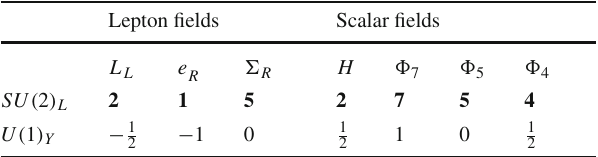
Table 1 Contents of fermion and scalar fields and their charge assign- ments under SU ( 2 ) L × U ( 1 ) Y Lepton fields